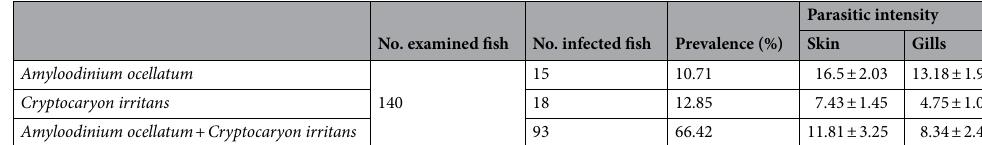
No. examined fish No. infected fish Prevalence (%)